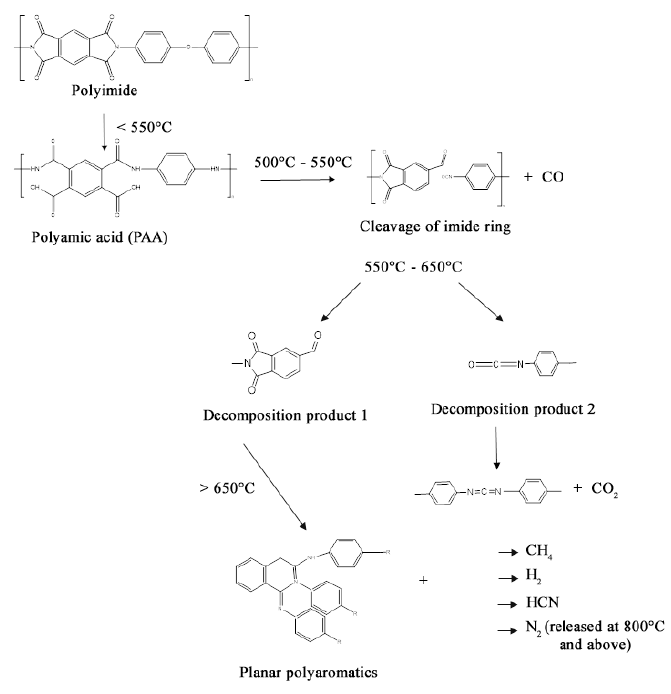
Figure 2. Predicted pyrolysis mechanism [29] .